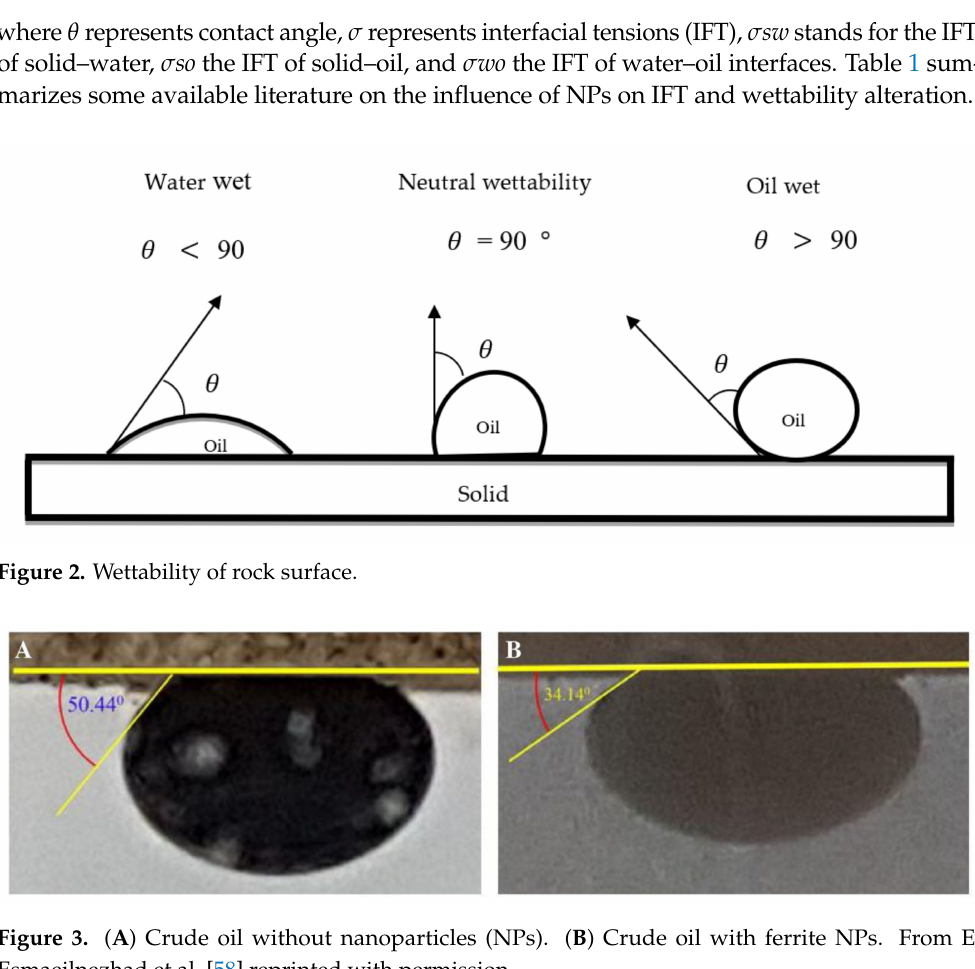
Figure 3. ( A ) Crude oil without nanoparticles (NPs). ( B ) Crude oil with ferrite NPs. From E. Esmaeilnezhad et al. [58] reprinted with